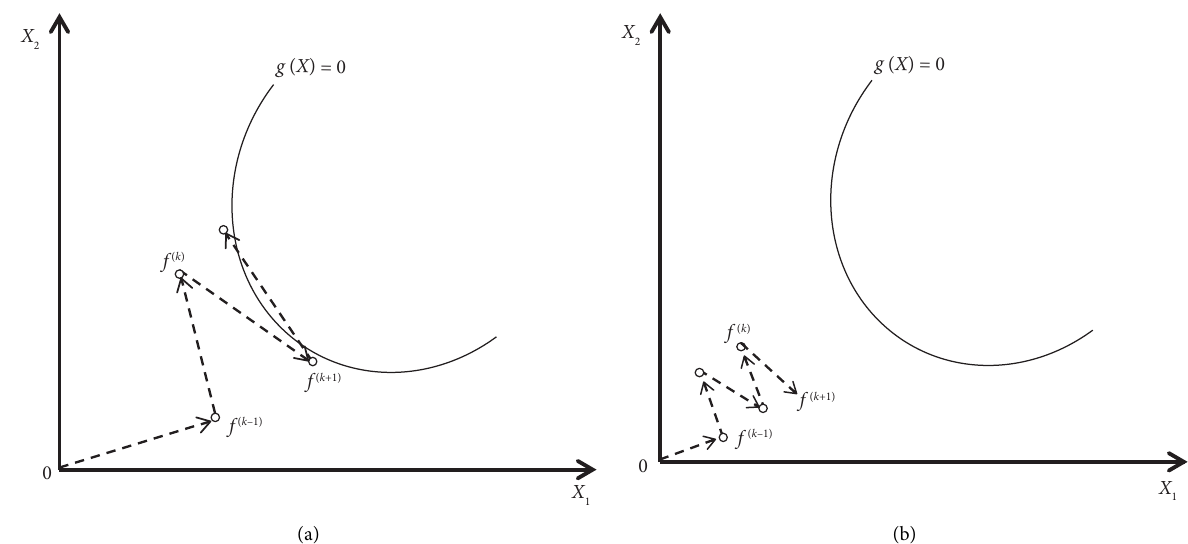
Figure 2: Traditional iterative process diagram. (a) Large step size. (b) Small step size.